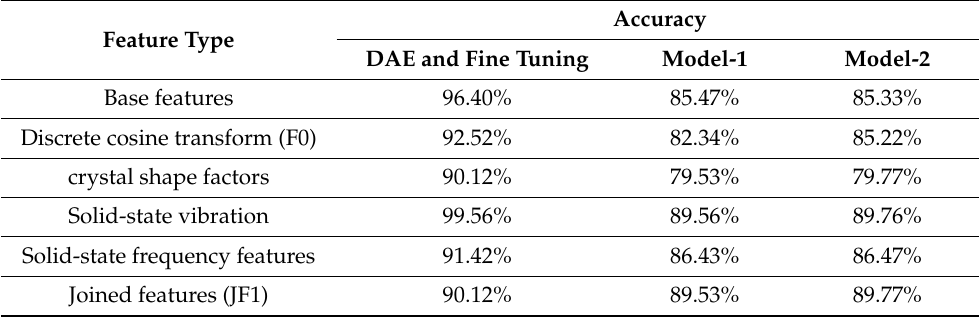
Table 12. Comparison of Accuracy of Model-1, Model-2 and our models (DAE and Fine Tuning) with Individual Feature.